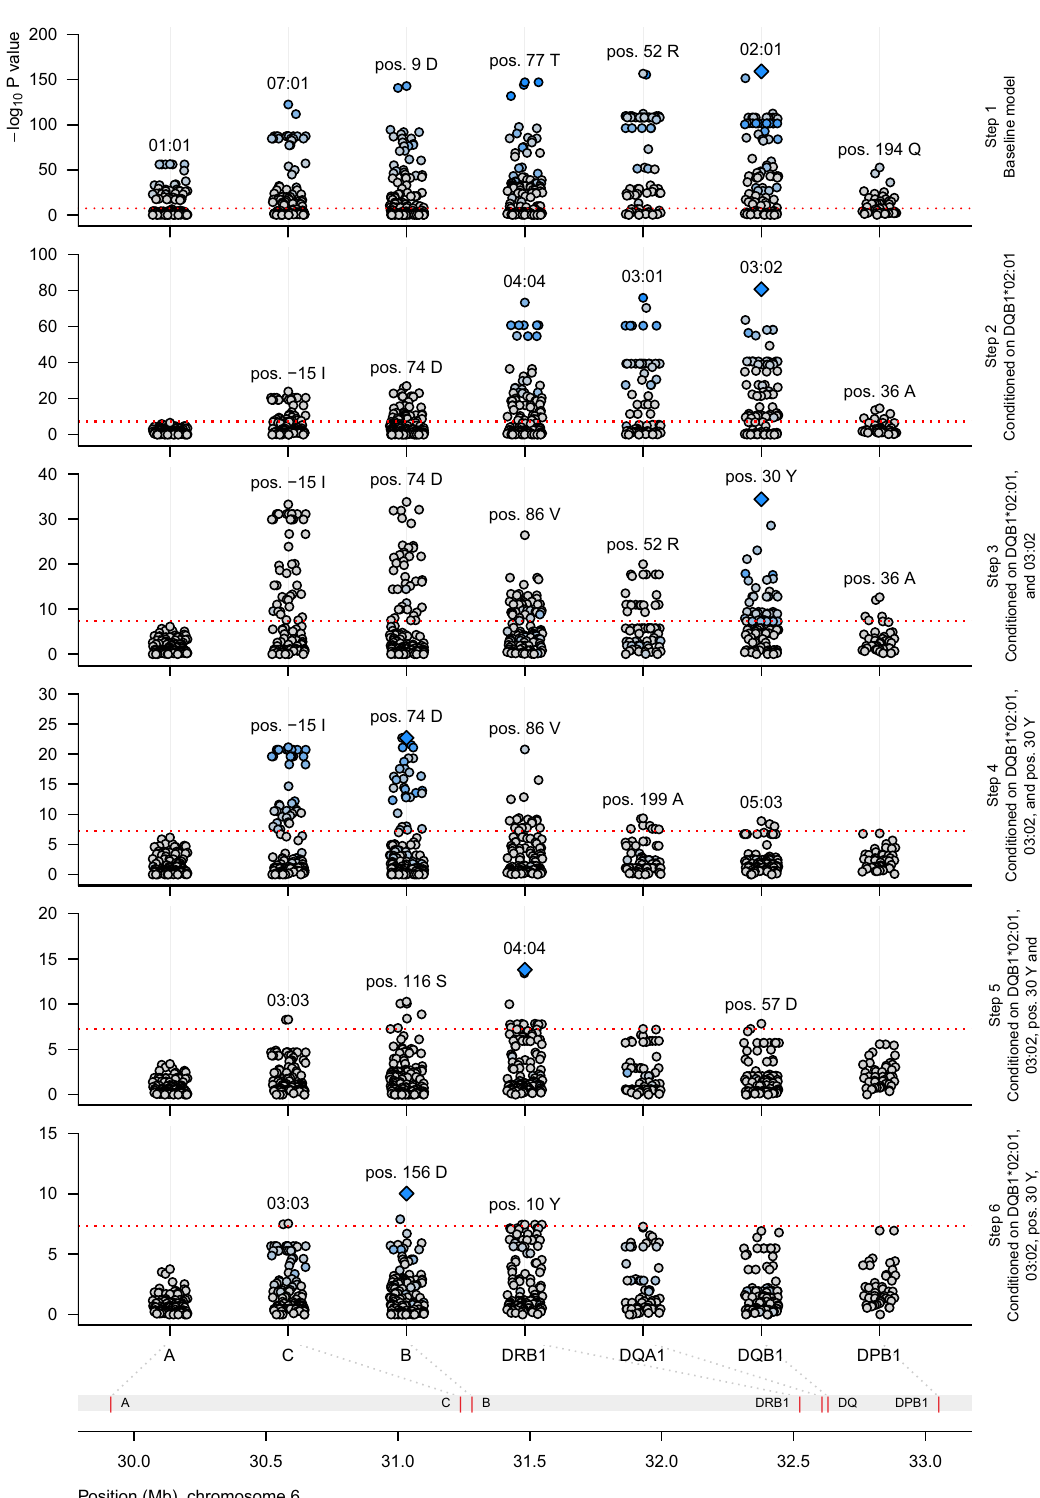
Fig. 3 Stepwise regression of the HLA association identi fi es the major genetic determinants of autoimmune Addison ’ s disease. The fi gure displays the results from the fi rst six steps of regression modeling of the HLA risk effects — alleles and amino acids. Starting with a baseline model comprising sex and fi ve principal components as covariates, we tested every allele and amino acid in turn for association with AAD (Supplementary Note). Additive, recessive, dominant, overdominant, and general variable encodings were compared with likelihood ratio tests and/or Bayesian information criterion. The allele or amino acid residue with most compelling evidence for association was included in the model at every step, and reconsidered at all subsequent steps. Downstream regression models were conditioned on the effects selected from previous models. The y- axes show the – log 10 P values from stepwise logistic regressions of 1223 cases and 4097 controls. The dashed horizontal lines indicate genome-wide signi fi cance ( P < 5 × 10 − 8 ). Diamonds mark the most signi fi cant effect. Blue color indicates strong linkage disequilibrium ( r 2 ) with the most signi fi cant effect, gray color indicates no